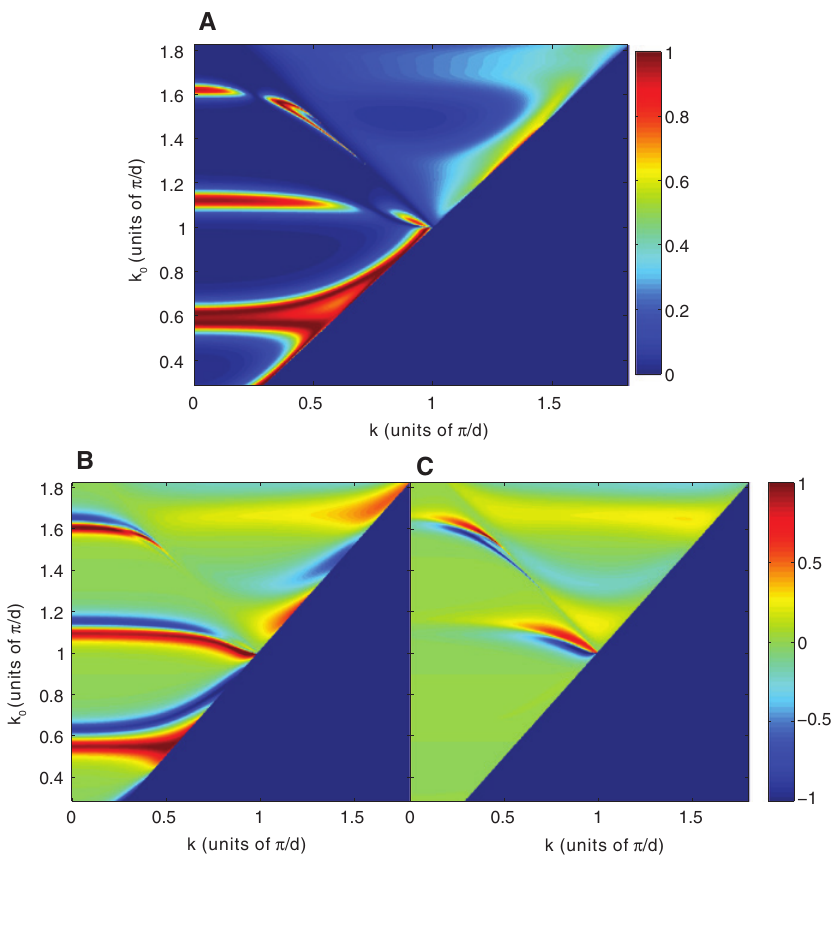
= h = 1.6 d , a = 0.25 d , and h = 0.5 d . Discontinuities in the dispersion curves can 1 3 2